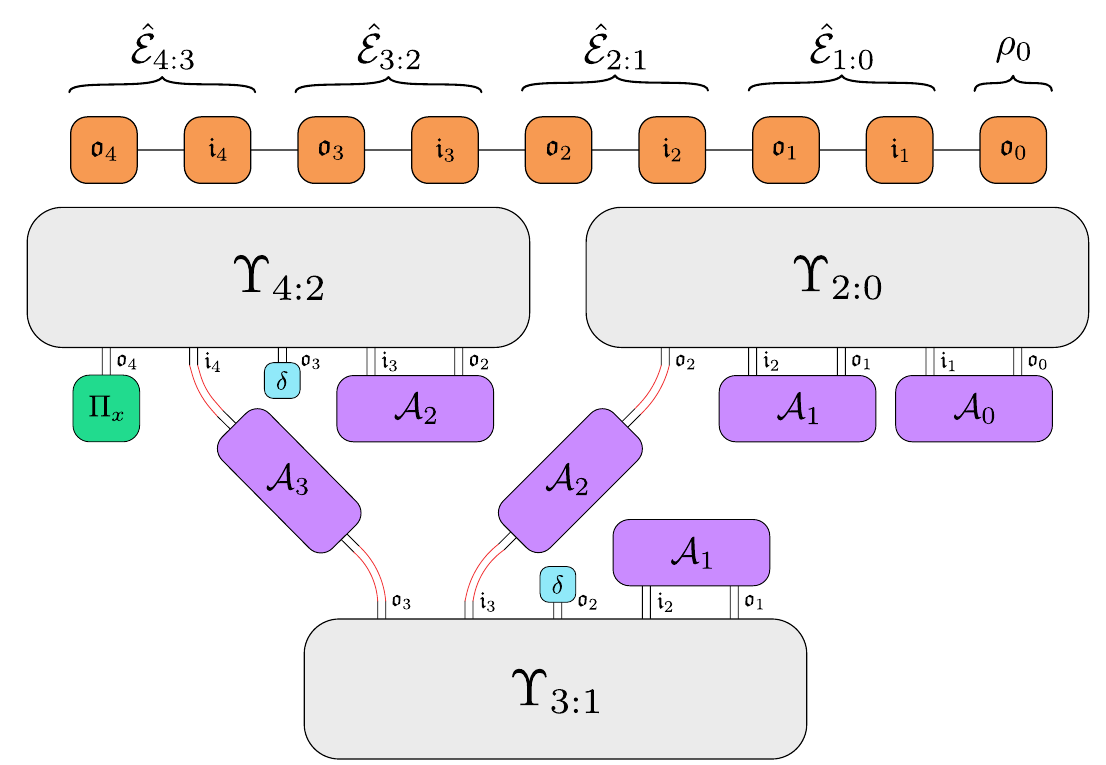
FIG. 6. A contraction strategy for mapping multitime gate sequences using a conditional Markov order ansatz. Here, we show how a four-step process can be modeled by two-step memory process tensors. The memory process tensors are stitched together by first contracting the relevant operations to their times to account for correlations. After tracing over the state output (denoted by δ ), the conditionally independent parts can be treated as tensor products and thus stitched together with the latest common operation, where the output of the earlier process tensor is mapped to the input of the later